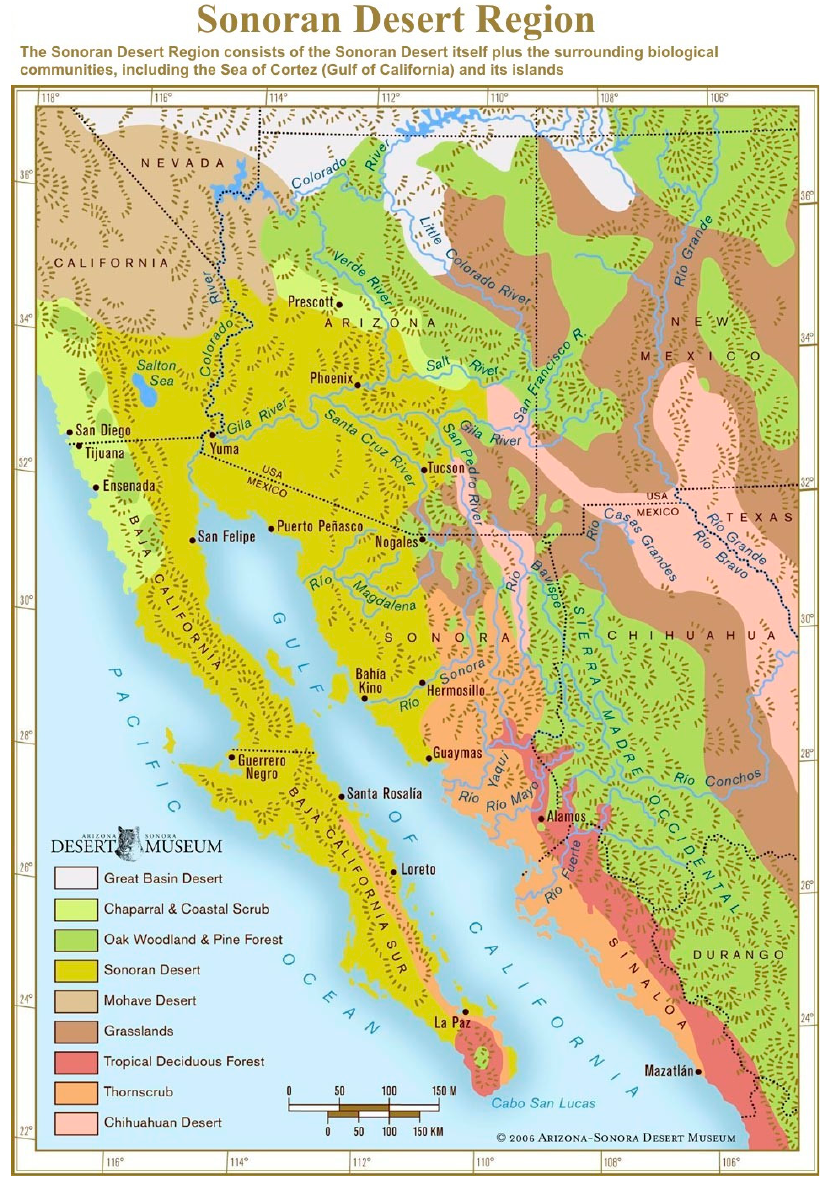
Figure 2. Sonoran Desert Region Biotic Communities .